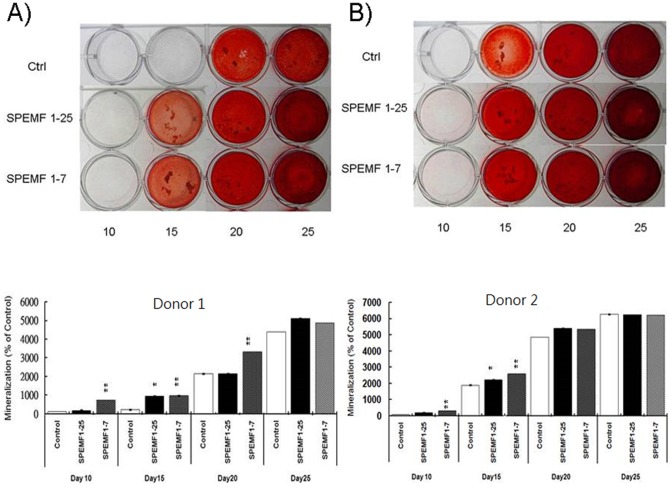
SPEMF increases the mineralization of hBMSCs.SPEMF 1–25 groups were stimulated with SPEMF from day 1 to day 25, while SPEMF 1–7 groups were stimulated from day 1 to day 7. Calcification deposits were collected on the 10th, 15th, 20th, and 25th day. (A) The mineral deposit of donor 1 hBMSCs was increased by SPEMF 1–7 stimulation on the 10th, 15th and 20th days, while by SPEMF 1–25 stimulation on the 15th day. (B) The mineral deposit of donor 2 hBMSCs was increased by SPEMF 1–7 stimulation on the 10th, and 15th days, while by SPEMF 1–25 stimulation on the 15th day. (P<0.05 *; P<0.01 **).